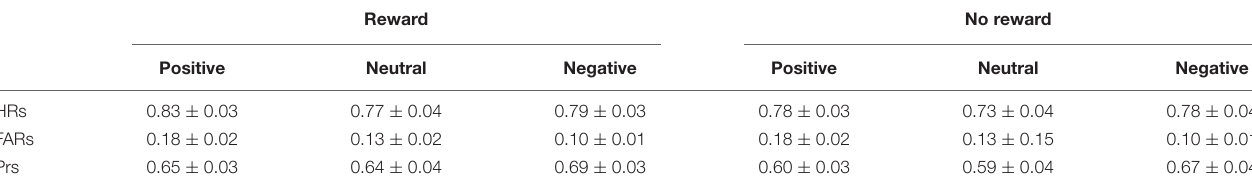
TABLE 2 | Mean Hit rates (HRs), False alarm rates (FARs), and Prs in each condition of old/new judgment. Reward